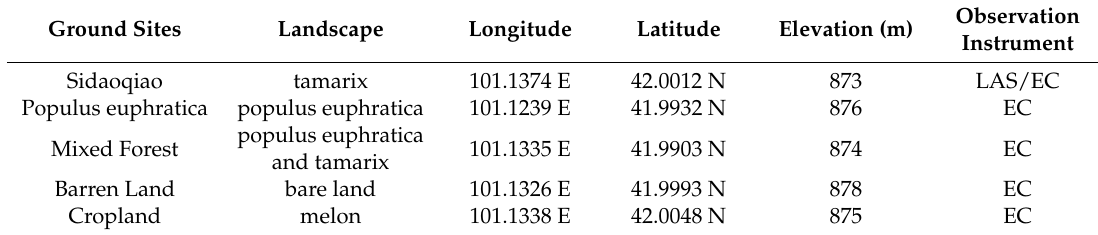
Table 1. Attributes of the test sites in the study area (Sidaoqiao).